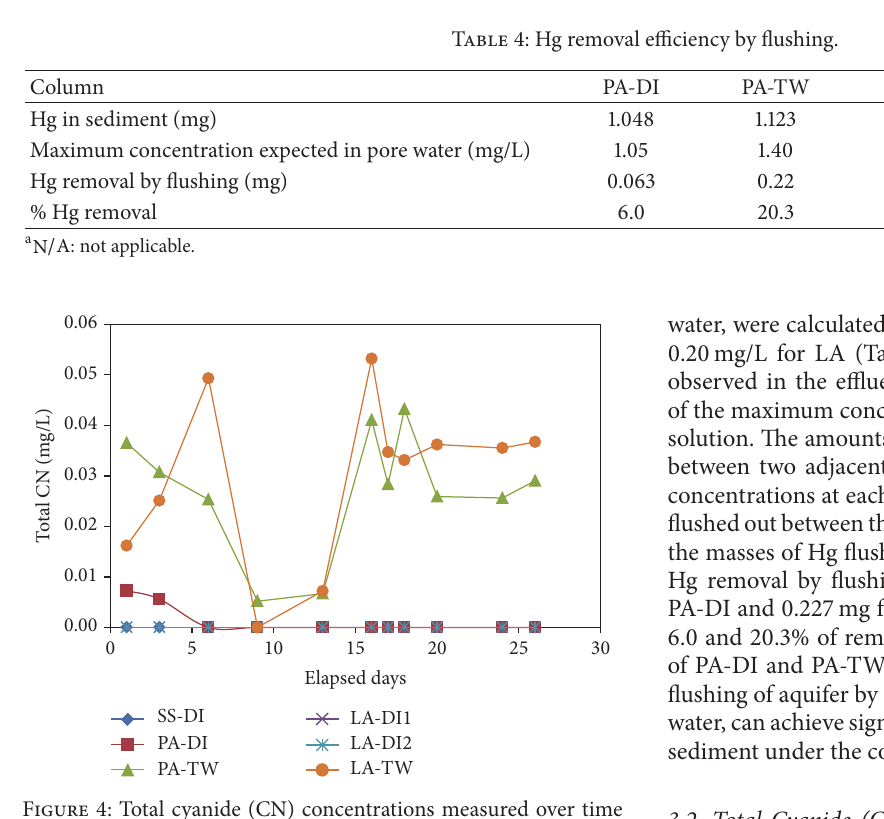
Figure 4: Total cyanide (CN) concentrations measured over time for each